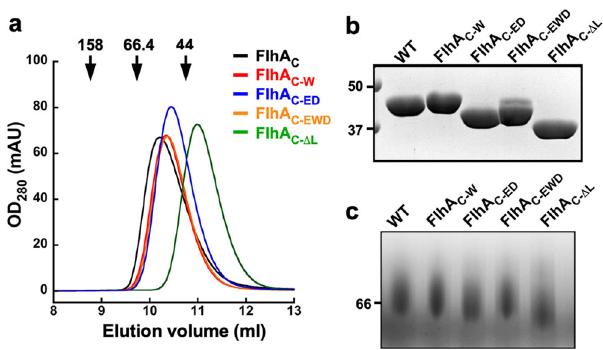
Fig. 5 Effect of FlhA linker mutations on the FlhA C conformation. a Hydrodynamic properties of FlhA C and its FlhA linker mutant variants. Puri fi ed protein samples (10 μ M) were run on a Superdex 75HR 10/30 column equilibrated with 50 mM Tri-HCl, pH 8.0, 150 mM NaCl. The elution peaks of His-FlhA C (WT, black), His-FlhA C-W (red), His-FlhA C-ED (blue), His-FlhA C-EWD (orange), and His-FlhA C- Δ L (green) are 10.2, 10.3, 10.5, 10.4, and 11.0 ml, respectively. Arrow indicates the elution peaks of γ - globulin (158 kDa), bovine serum albumin (66.4 kDa), and ovalbumin (43 kDa), which are 8.7, 9.7, and 10.7 ml, respectively. b CBB-stained SDS- PAGE gel of puri fi ed wild-type FlhA C and its mutant variants. The regions of interest were cropped from an original CBB-stained gel shown in Supplementary Fig. 8a. c Blue Native PAGE gel of puri fi ed wild-type FlhA C and its mutant variants. The regions of interest were cropped from an original Blue Native PAGE gel shown in Supplementary Fig.